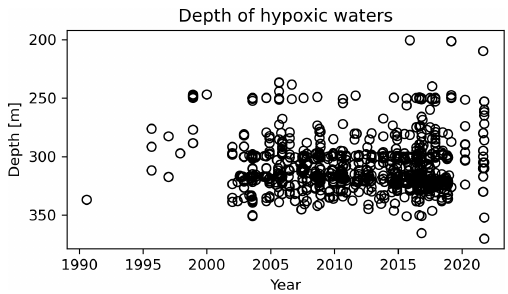
Figure 3. Depth of hypoxic waters, through time. Each point rep- resents one field observation of hypoxic waters (dissolved oxygen < 62.5µM) within the LSLE.